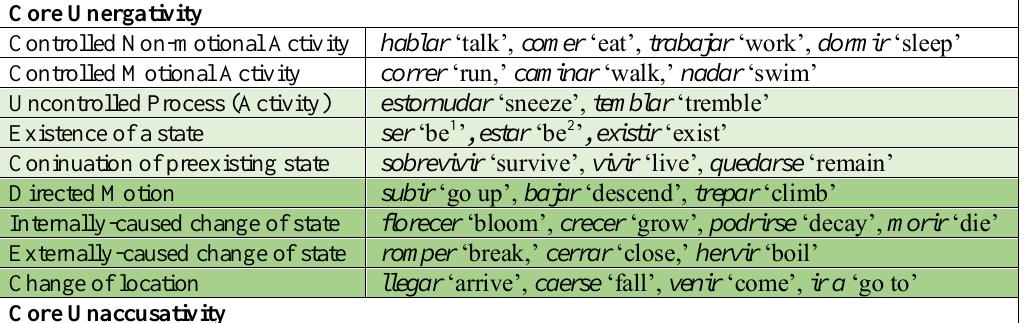
Table 8. The Unergative-Unaccusative Hierarchy Core